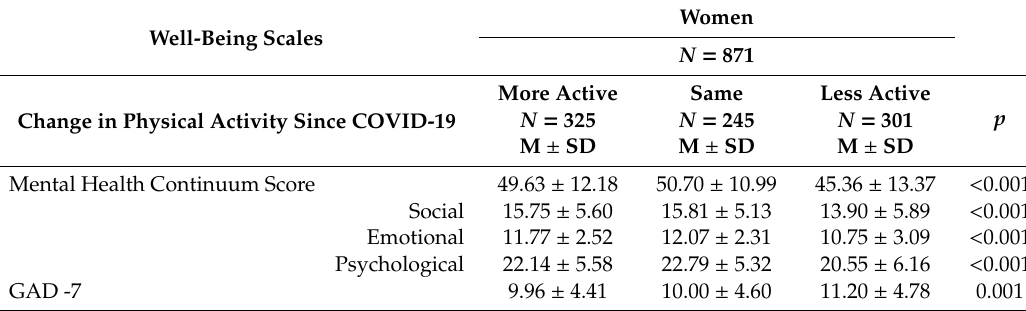
ANOVA results for well-being outcomes in relation to changes in physical activity since